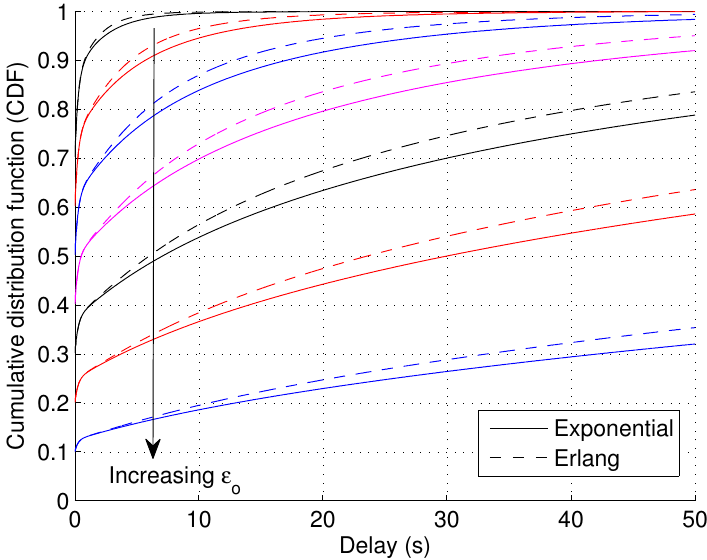
Figure 6. CDF of waiting time w II with varying coverage outage fraction ε o when the coverage outage duration β o follows the exponential and Gamma distribution ( ε o increases from 0.1–0.7 with steps of 0.1, k = 2, N = 1, ¯ α o = 20, ε e = 0.2, ¯ α e =